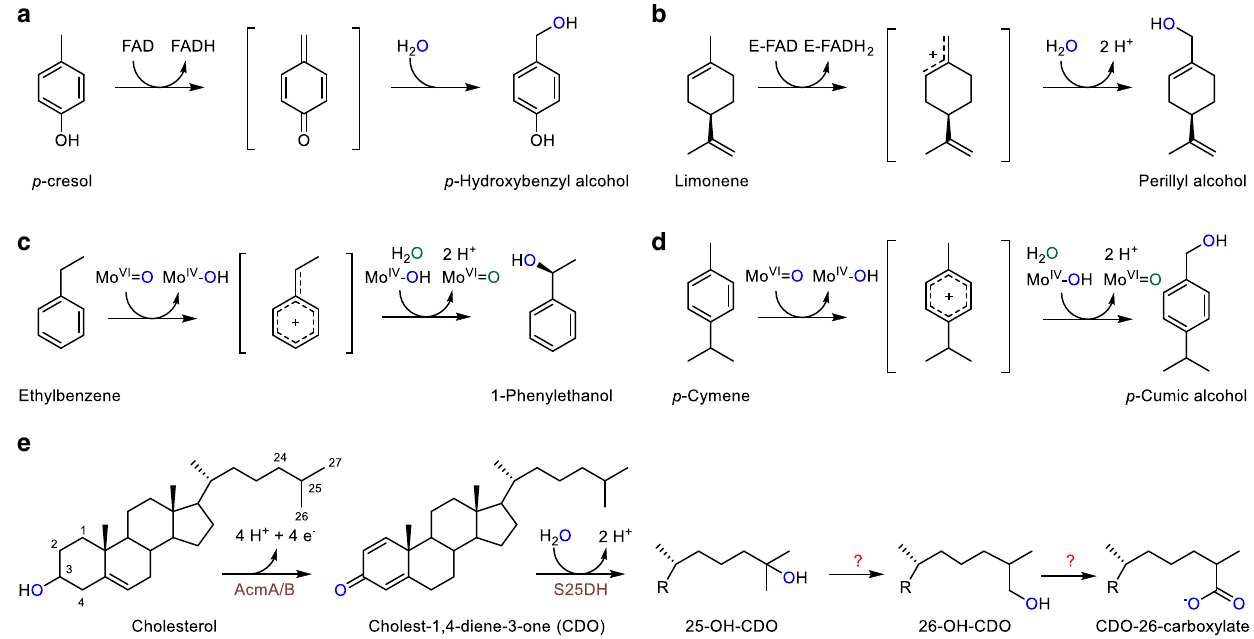
Fig. 1 Enzymatic water-dependent alkyl hydroxylations. a p -Cresol methyl hydroxylase. b Limonene dehydrogenase. c Ethylbenzene dehydrogenase. d p -Cymene dehydrogenase. e Initial steps of anaerobic cholesterol degradation. The enzyme cascade involved in the proposed conversion of 25-OH-CDO (25-OH-cholesta-1,4-diene-3-one) to CDO-26-carboxylate (cholesta-1,4-diene-3-one-26-carboxylate) via a 26-OH-CDO (26-OH-cholesta-1,4-diene-3- one) intermediate was studied in this